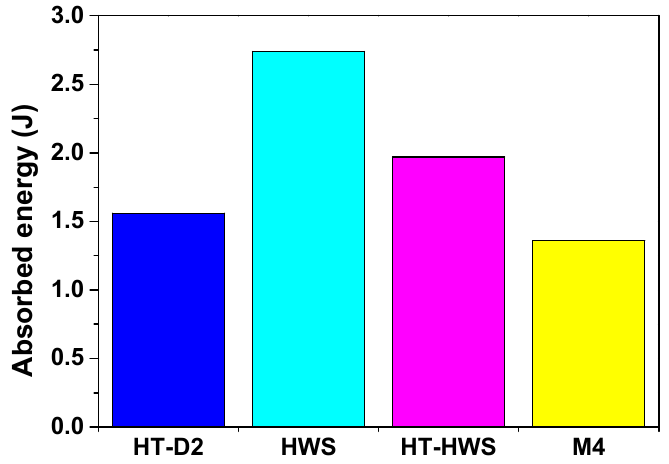
Figure 10. Total absorbed energy in the Charpy impact test.